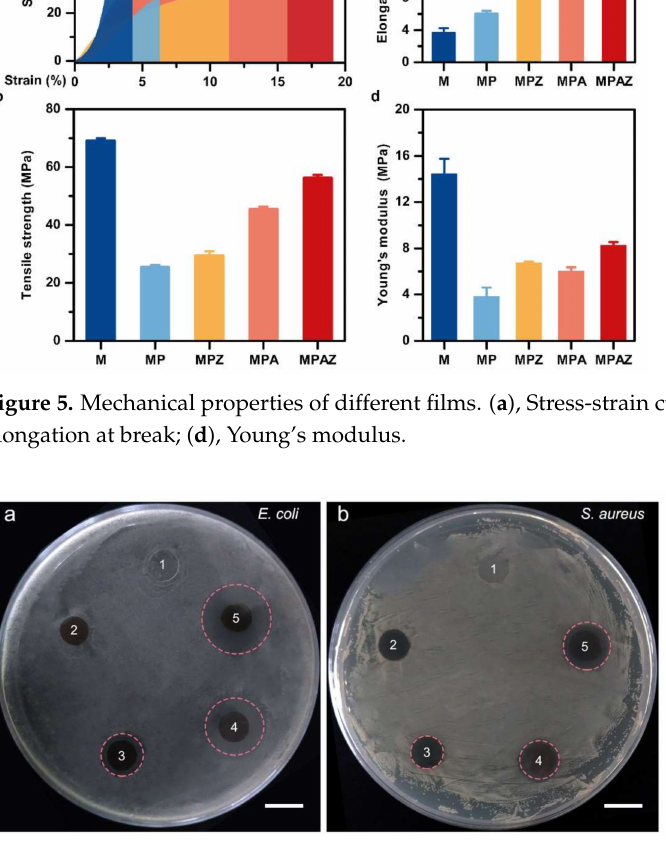
Figure 6. Inhibition zone assay of different films. ( a ), E. coli ; ( b ), S. aureus . 1–5, M, MP, MPZ, MPA, and MPAZ, respectively. Scale bar, 1